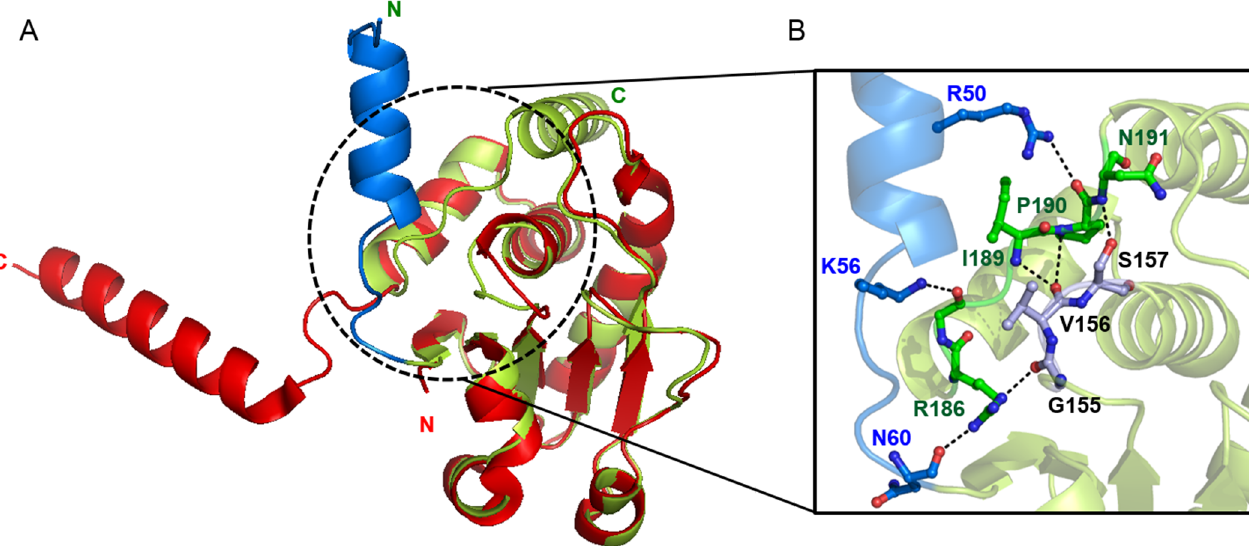
Fig 6. Critical role of the N-terminal region in the catalytic activity of DUSP26-N. (A) Superposition of the DUSP26-C monomer (red) onto the DUSP26-N (C152S) monomer (green). The black dotted circle highlights the large conformational difference in the α 7- α 8 loop between DUSP26-N (C152S) and DUSP26-C. The additional N-terminal region (residues 39 – 60) of DUSP26-N (C152S) is colored blue. (B) Hydrogen bonding interaction network among the PTP-loop, its surrounding α 7- α 8 loop, and α 1-helix in DUSP26-N (C152S). Residues in the PTP-loop (Gly155, Val156, and Ser157) and the N-terminal domain (Arg50, Tyr53, and Lys56) form hydrogen bonds with residues in the α 7- α 8 loop. The residues in the N-terminal domain, α 7- α 8 loop, and PTP-loop are shown as light blue, green, and dark blue, respectively. Hydrogen bonds are indicated by dotted